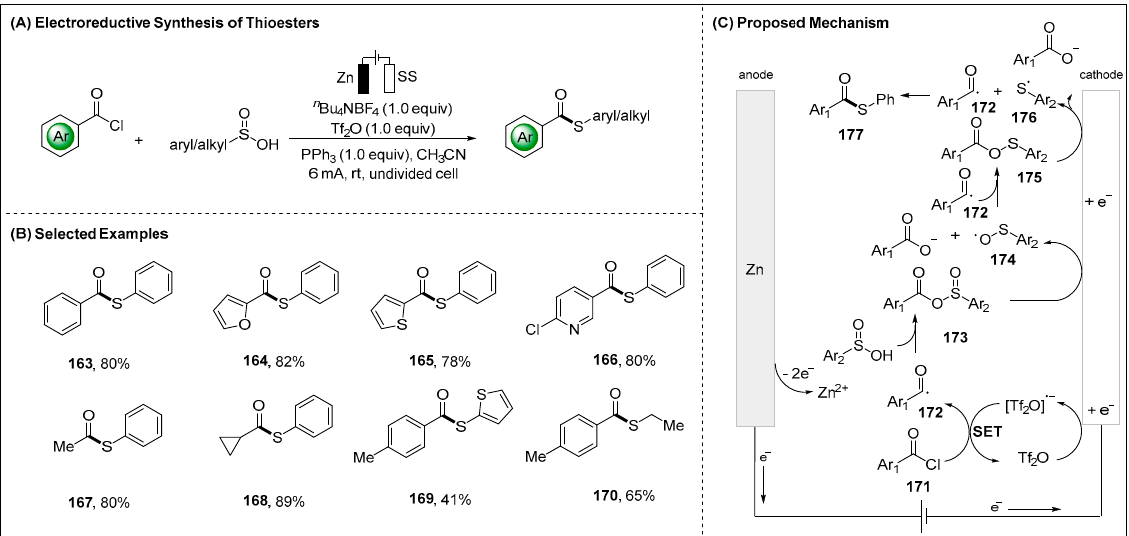
Figure 20. Electroreductive cross-coupling between acyl radicals and thiyl radicals by Lei group.